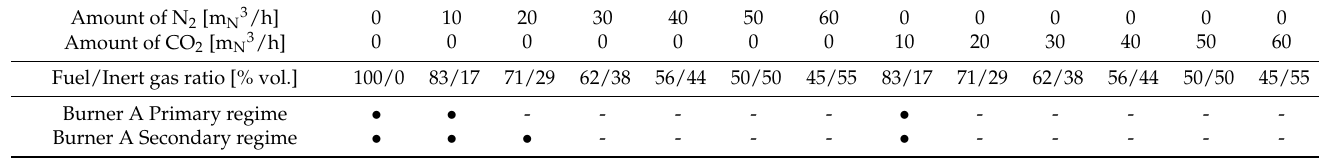
Table 2. Experimental matrix—TEST A—Burner A ( • indicates that the test was carried out). Amount of N 2 [m N3 /h]